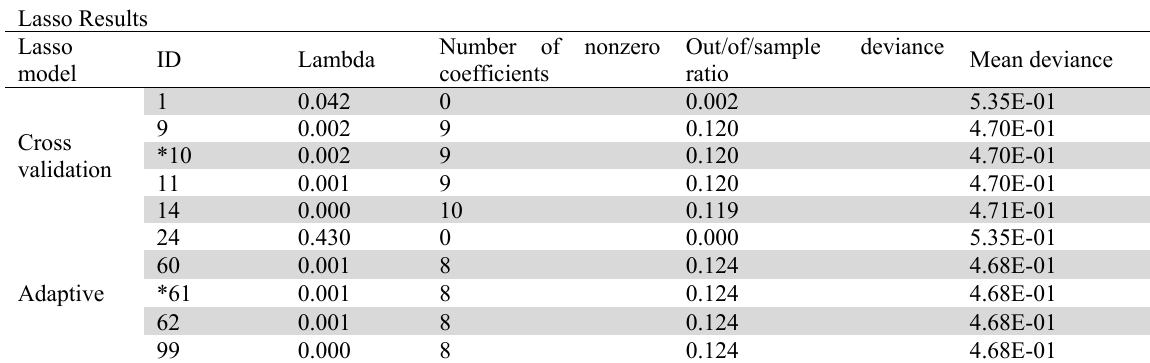
Table 2 Lasso Results